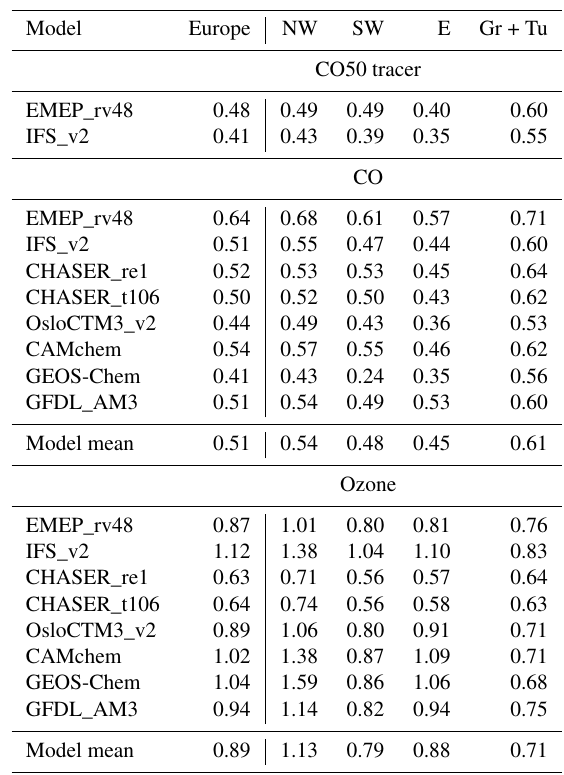
Table 3. Annual RERER values for Europe (total for all European subregions) and the European subregions shown in Fig. 1 for the CO tracer, CO and O 3 .